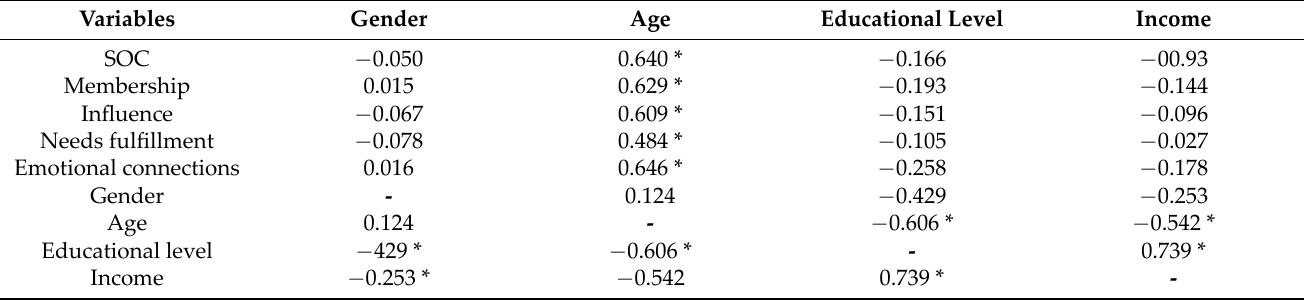
Table 4. Demographic characteristics of